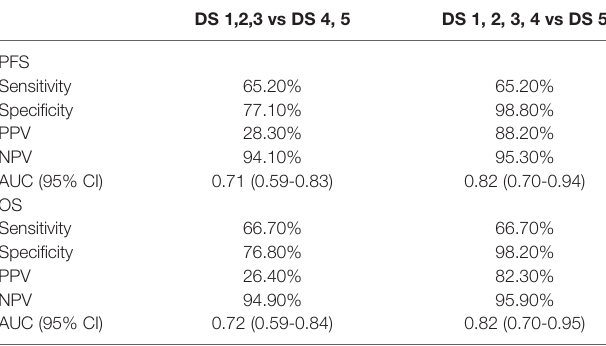
TABLE 3 | Sensitivity, speci fi city, predictive values and AUC for